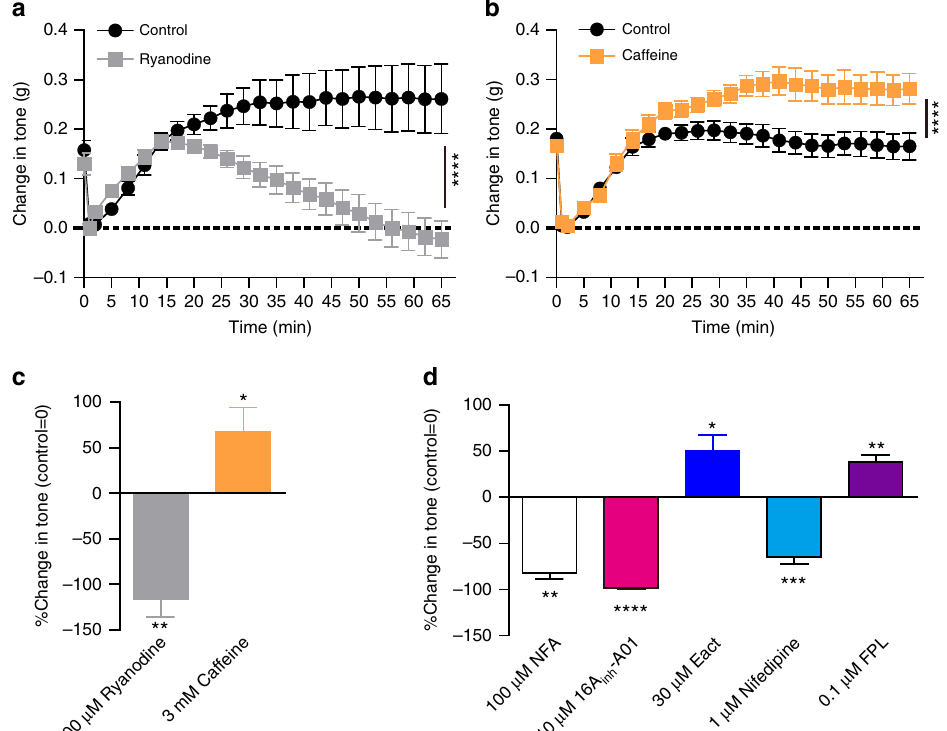
Figure 2 | RyRs, Cl Ca channels and VDCCs are essential for the basal tone in IAS. ( a ) Ryanodine (100 m M) significantly decreased the spontaneous tone in IAS. Bars represent mean ± s.e.m., control n ¼ 5, ryanodine n ¼ 6, **** P o 0.0001 by analysis of variance (ANOVA) comparing the sustained phases. ( b ) Caffeine (3mM) increased the tone in IAS. Bars represent mean ± s.e.m., n ¼ 7, **** P o 0.0001 by ANOVA comparing the sustained phases. ( c